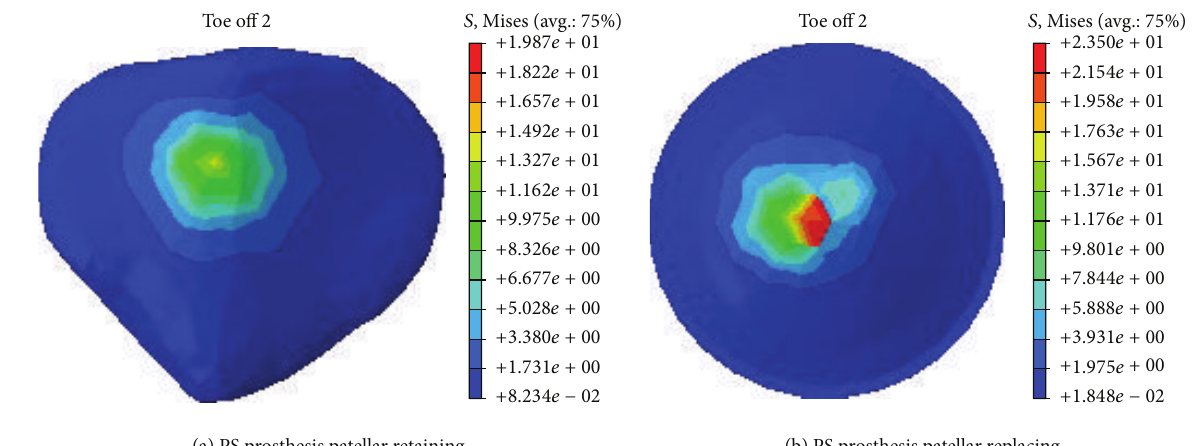
Figure 9: Contours of equivalent stress in patella and patellar implants during the gait cycle.